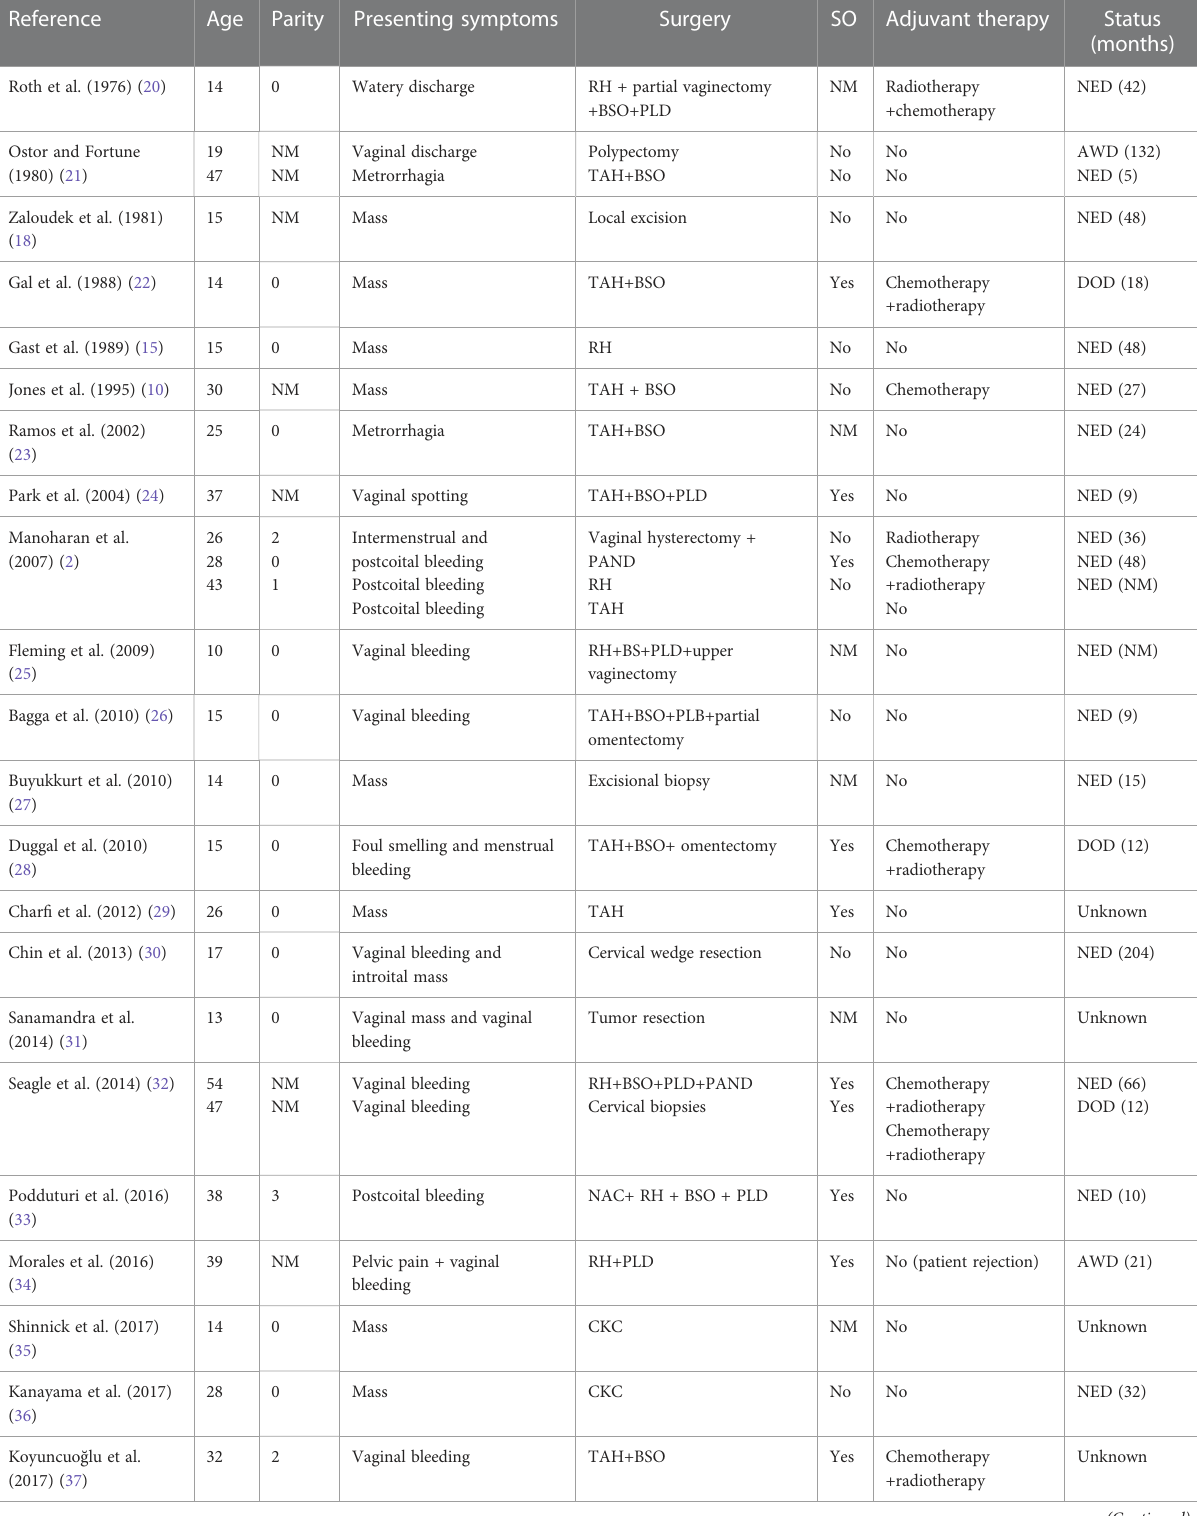
TABLE 1 Clinicopathologic characteristics of Müllerian adenosarcoma of the cervix in chronological